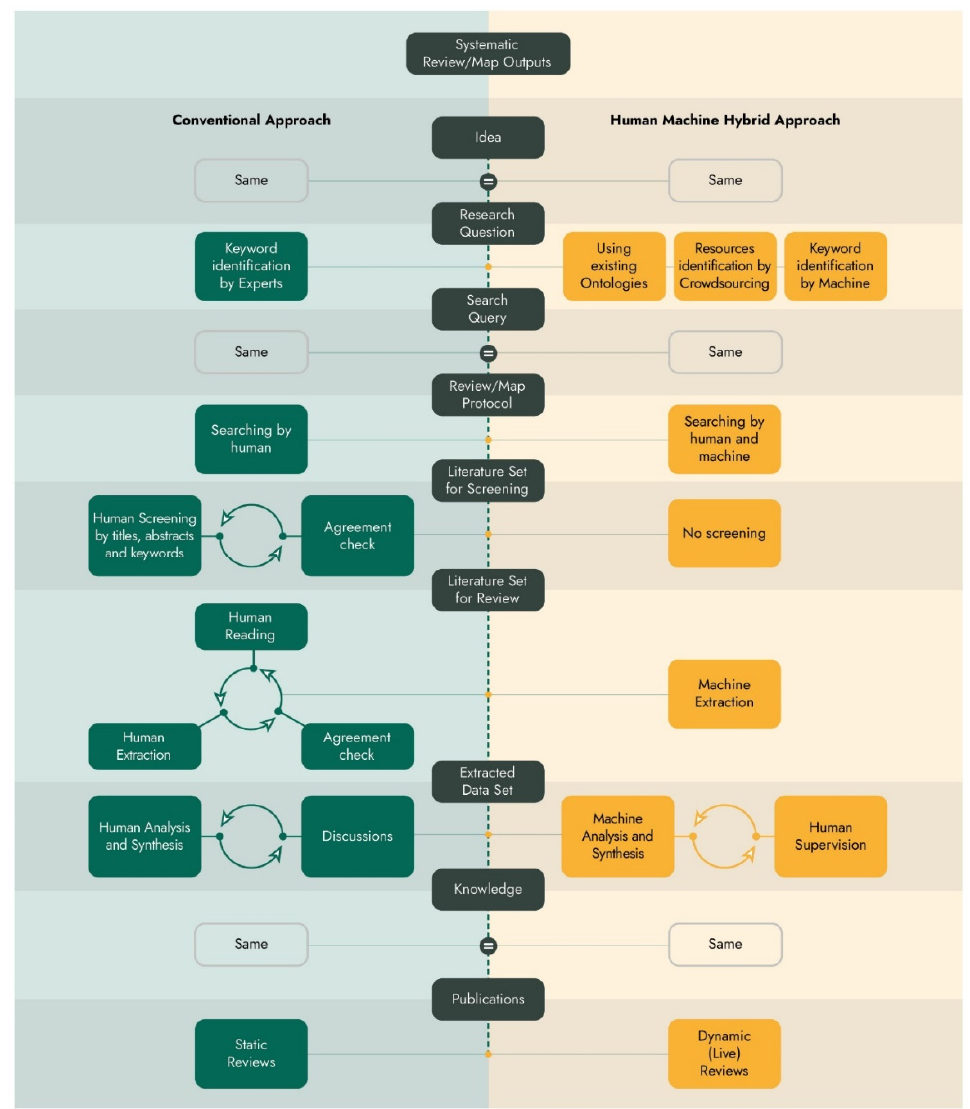
Figure 1. Comparison of Conventional and the Human Machine Hybrid Approach to Systematic Reviews and Maps. The boxes in the central line present the primary outputs or milestones in a systematic review/map. The left (green) and the right (yellow) sections show different tasks in the conventional and hybrid approaches. When there is a difference between the approaches, there are multiple boxes that indicate the differences. When the tasks are not different between the two approaches, either a box with “same” was used, or detailed parts of the tasks were not omitted for improving the accessibility of the figure. For instance, in the conventional approaches, the end product is static reviews. In contrast, in the hybrid approach, the end product is dynamic (live) reviews, i.e., the reviews that can be updated using the recent evidence sources without significant efforts and reviewer time.